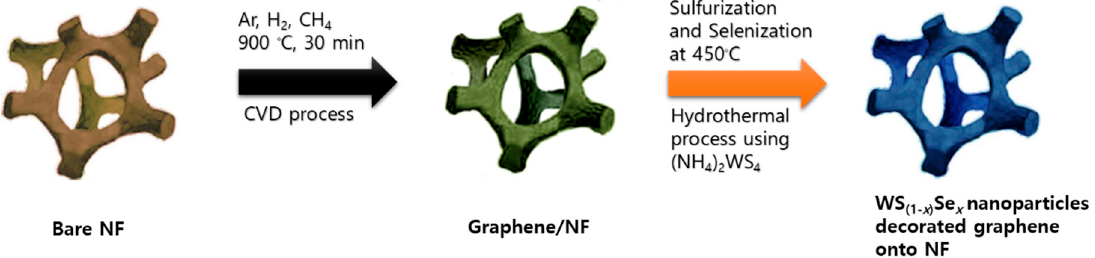
Figure 1. Schematic preparation process of graphene and the WS (1 − x ) Se x /graphene/NF catalyst.